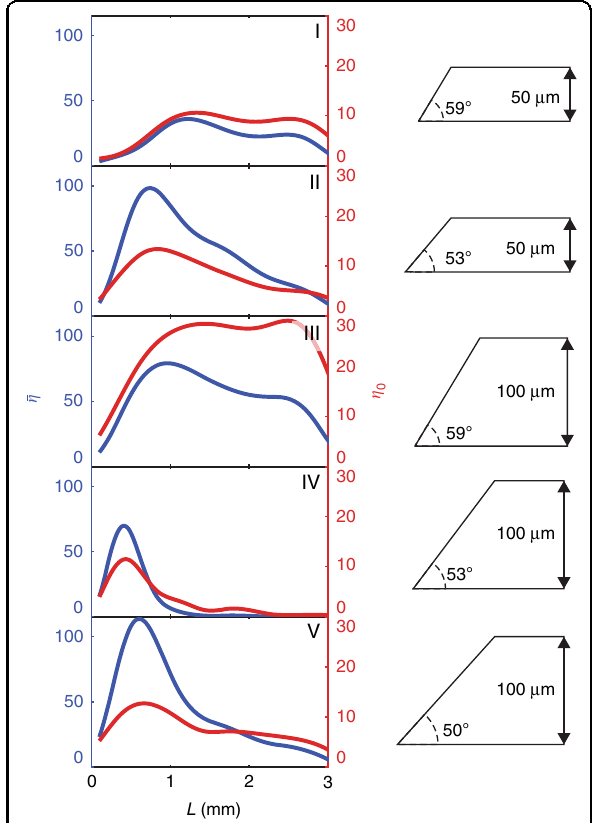
Fig. 4 THz buildup plots. Integrated enhancement ( η ) in blue, and buildup enhancement ( η ) in red, plotted for each sample as a 0 function of buildup distance ( L ). Sample thickness and angle are shown by the diagram at the right of each plot